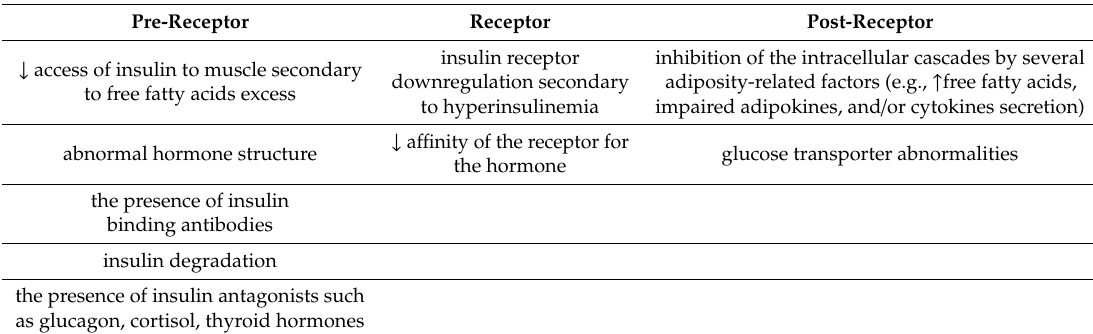
Table 2. The mechanisms involved in the etiopathogenesis of insulin resistance related to obesity